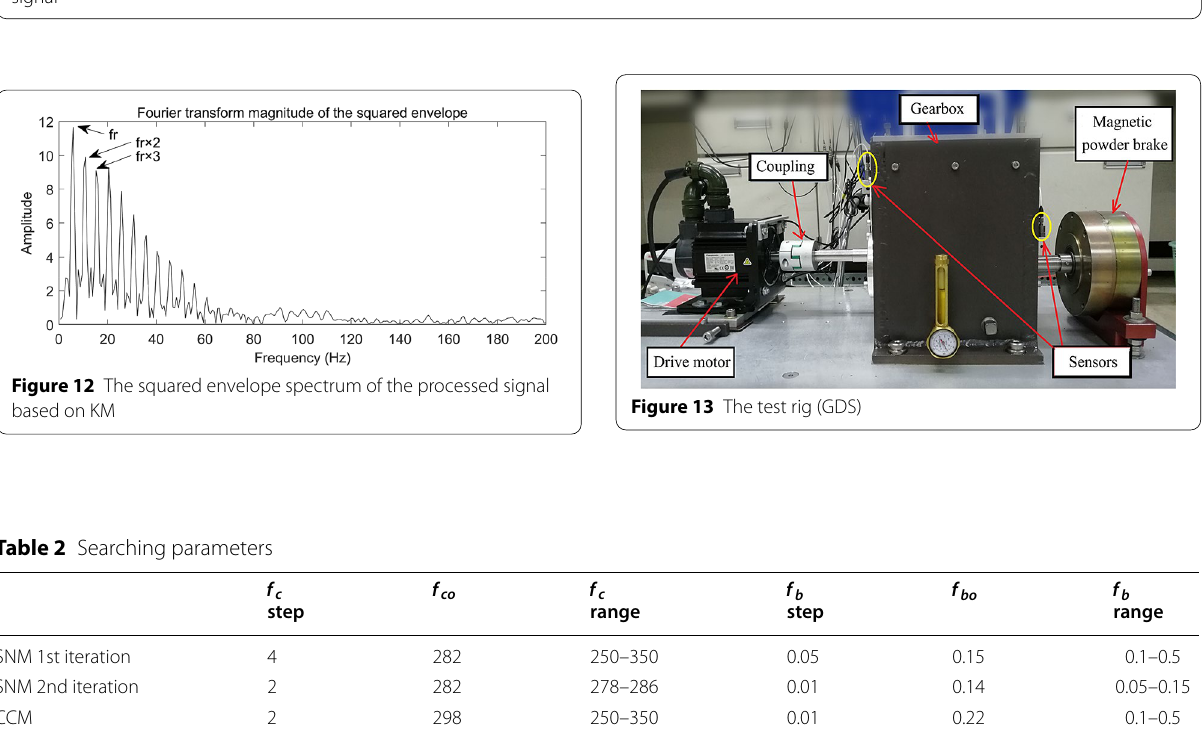
Figure 11 Simulation signal processed by KM: ( a ) original signal, ( b ) signal after filtering by impulsive wavelet, and ( c ) envelope of the processed signal